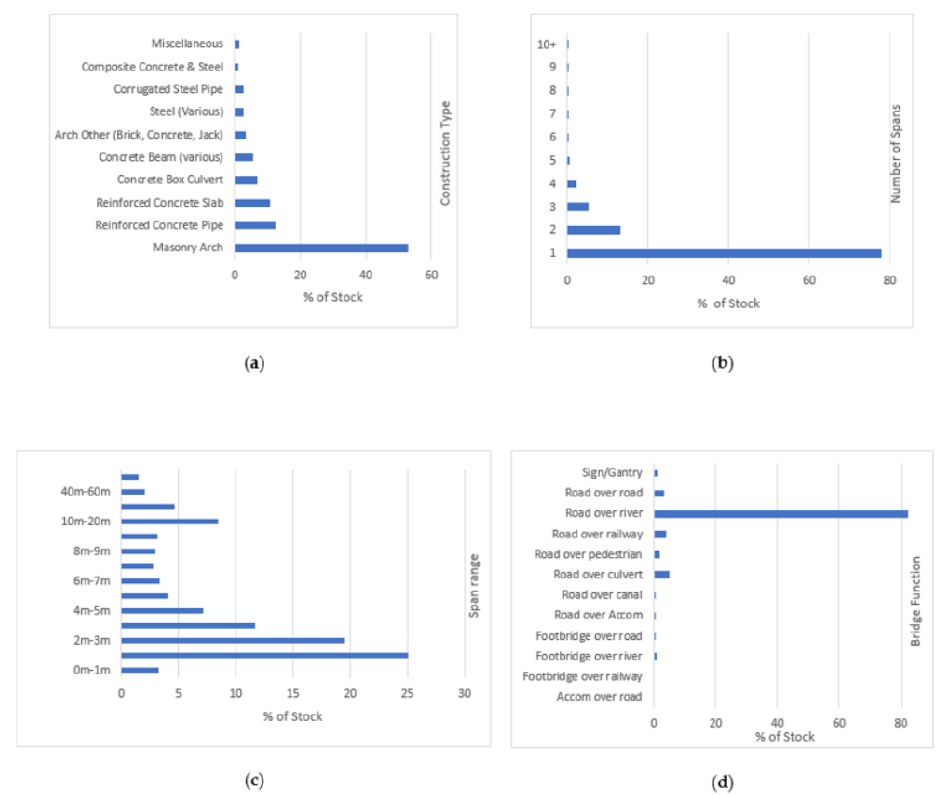
Figure 1. Overview of bridge stock on Northern Ireland road network: ( a ) span construction type; ( b ) number of spans; ( c ) cumulative span range; ( d ) bridge